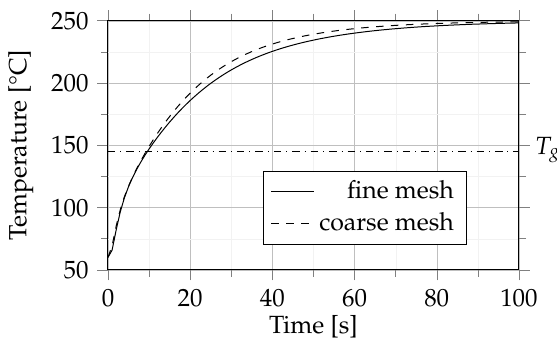
Figure 9. Temperature of considered composite for two meshes; coarse: 1.5 million cells and fine: 2.2 million cells. The dash-dotted line indicates the glass transition temperature ( T g ) of 145